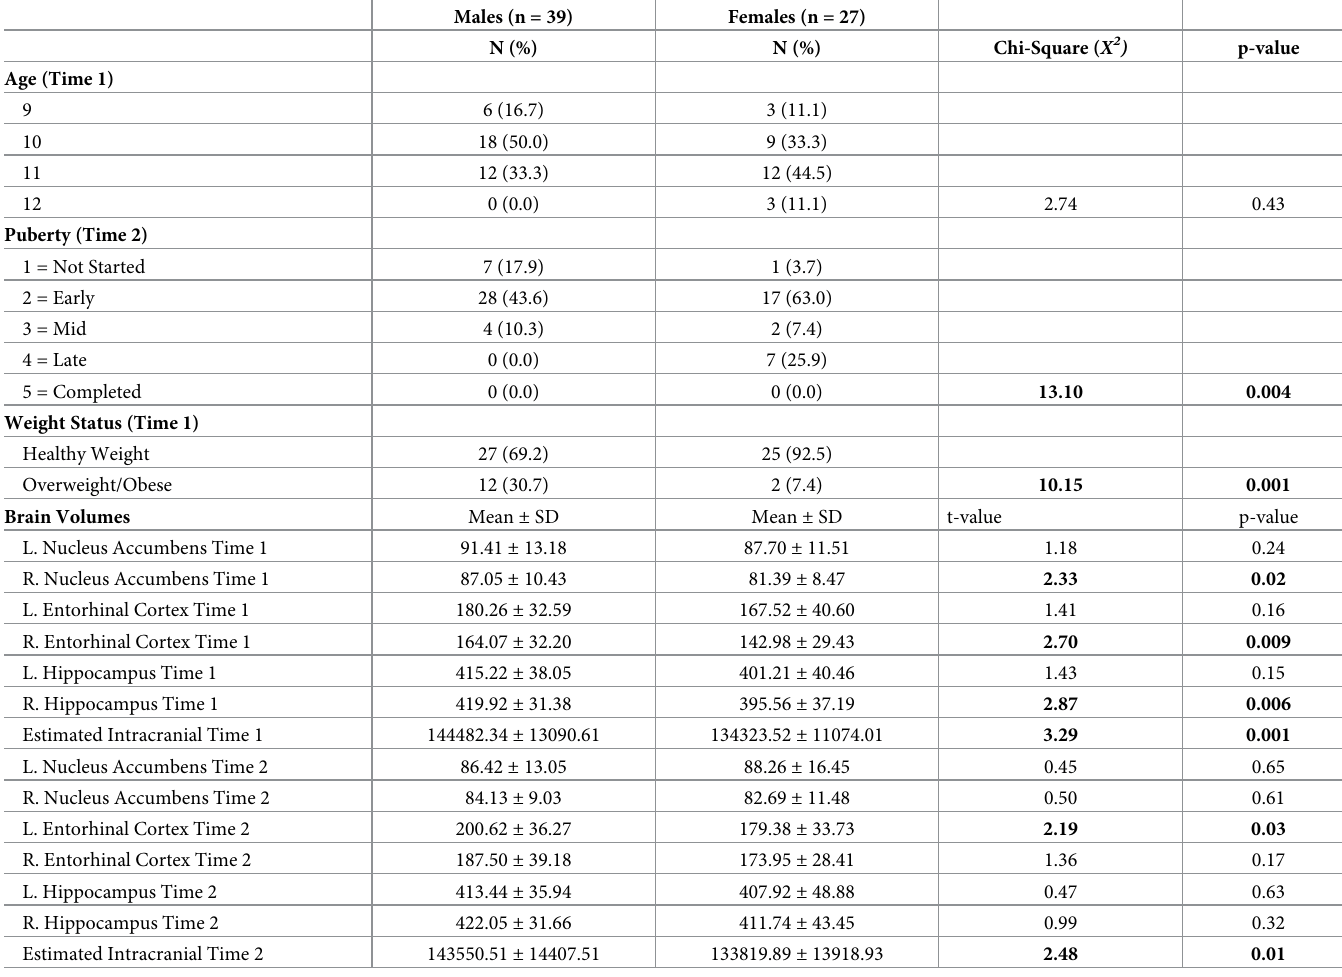
Table 1. Participant characteristics stratified by